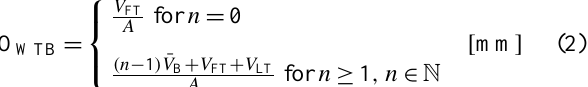
Fig. 3. Run-off event from concrete pavement at the 3 Septem- ber 2009 in Berlin-Marienfelde, Germany. The run-off event was studied using the weighable tipping bucket. Indicated are the filled bucket volumes at the beginning ( V FT ) and at the end of the run-off event ( V LT ) as well as the beginning ( B P ) and the end ( E P ) of the precipitation